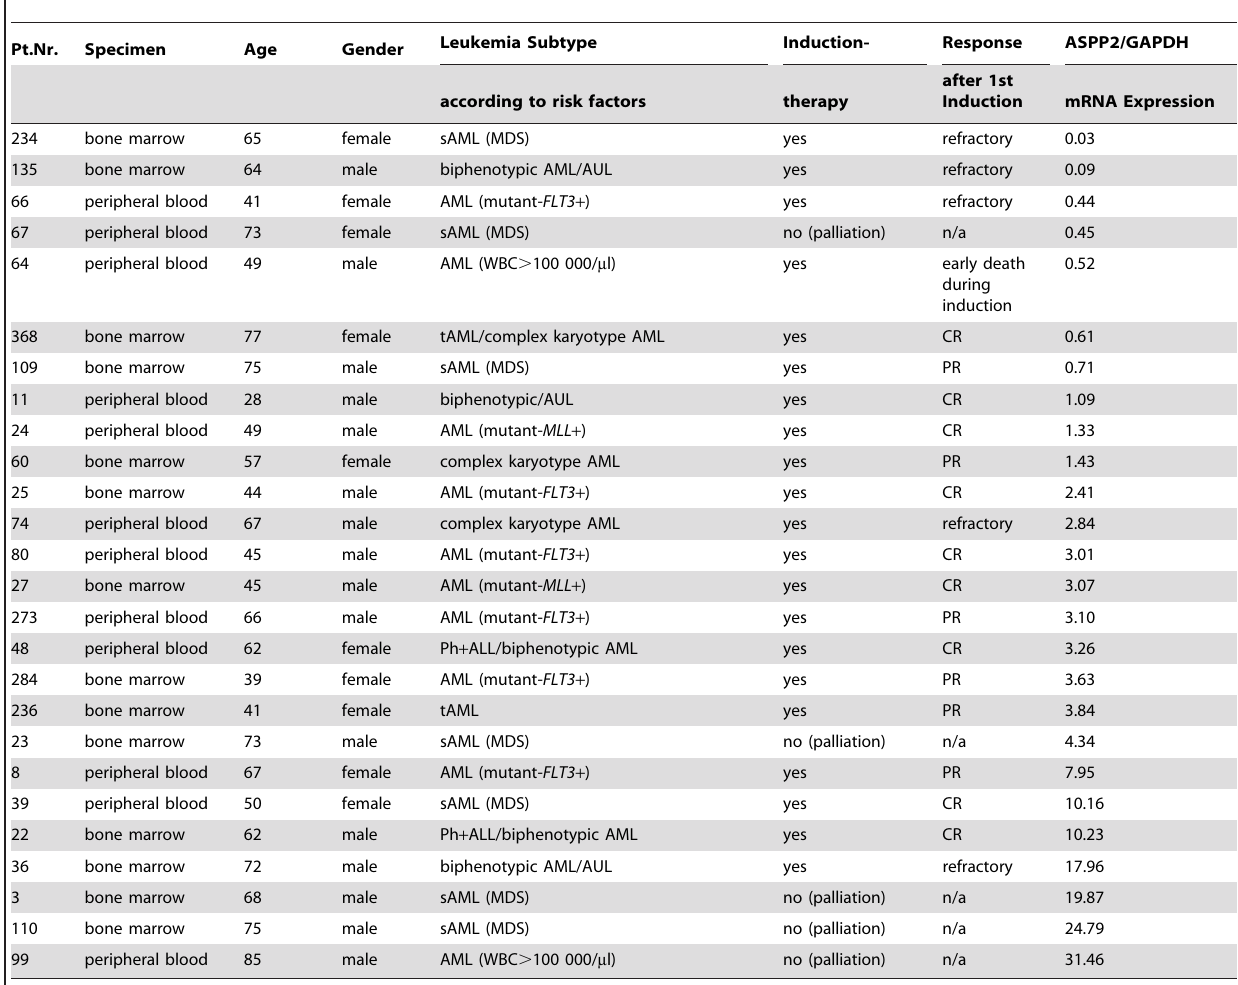
Table 2. Patient Characteristics (mRNA Assay): Higher-Risk Cohort.